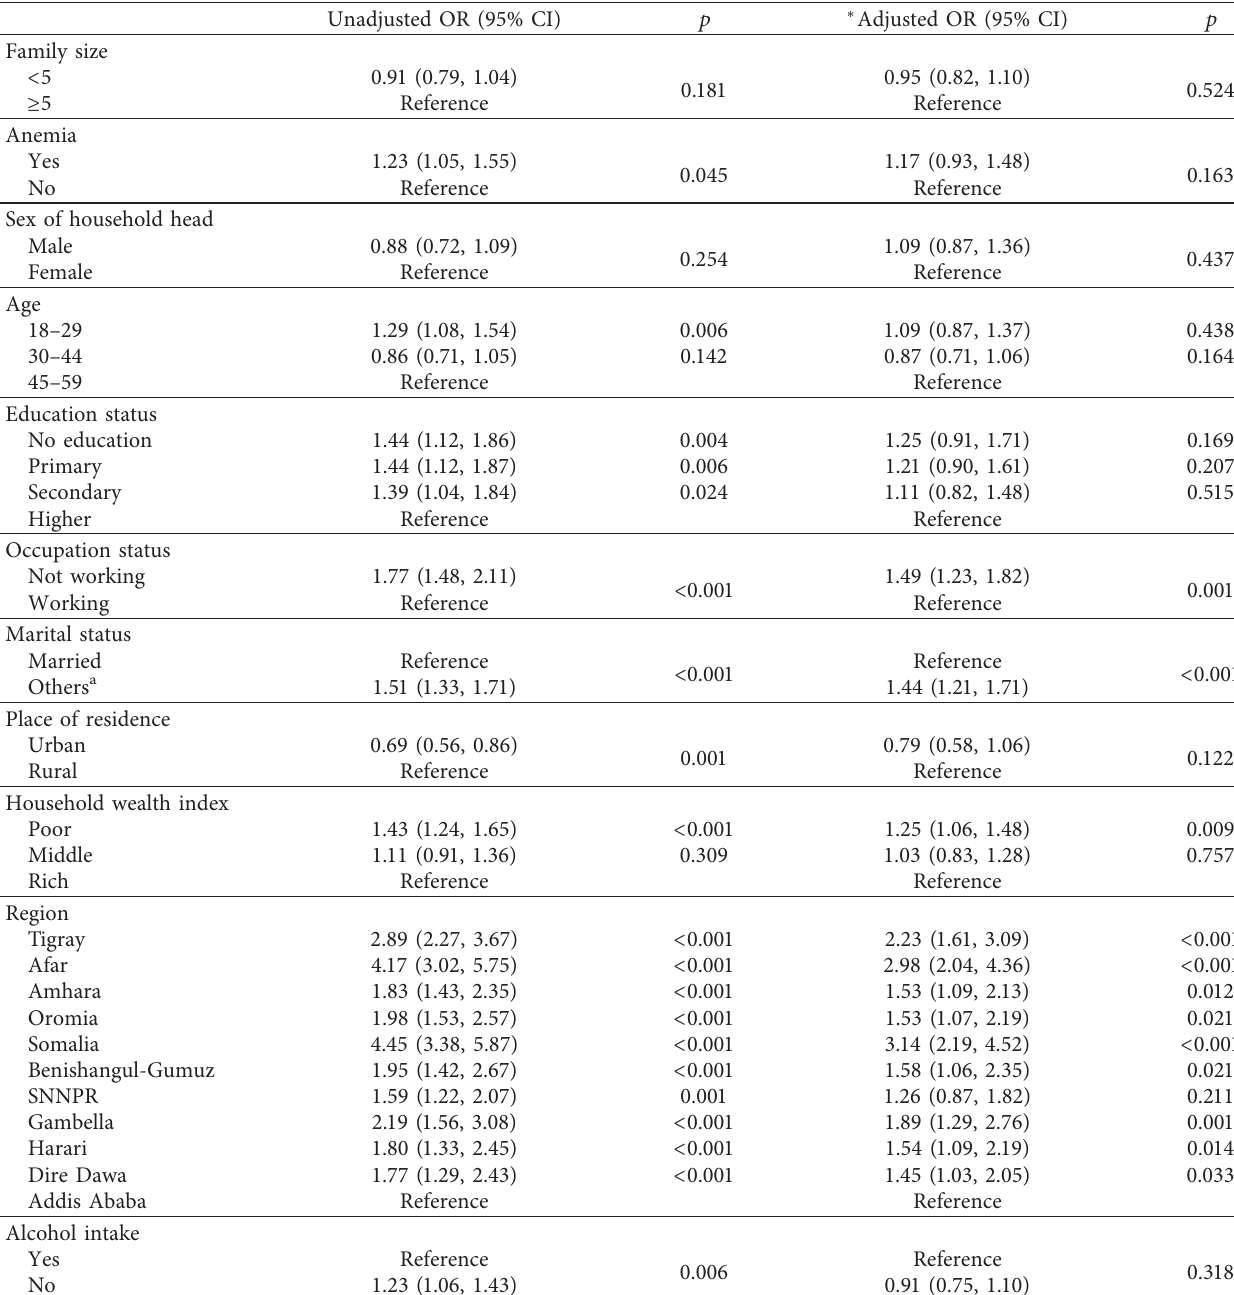
Table 3: Factors associated with chronic energy deficiency among adults aged 18–59 years in Ethiopia: EDHS 2016 ( N � 9280). Unadjusted OR (95%